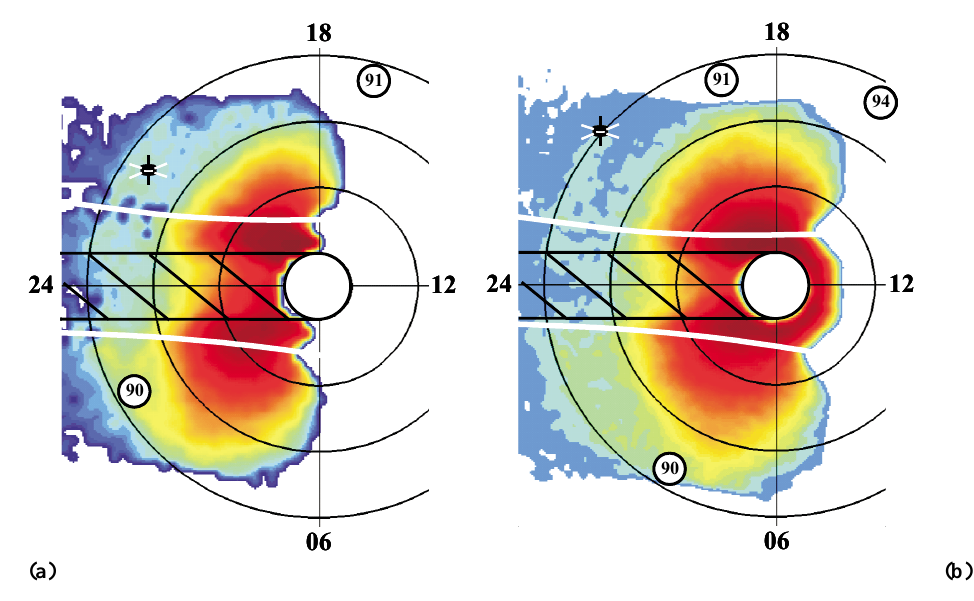
Fig. 19. Projection of a full-frame EUV image onto the magnetic equatorial plane on 11 April 2002 (a) at 04:31 UT, (b) at 06:14 UT (similar as Fig.